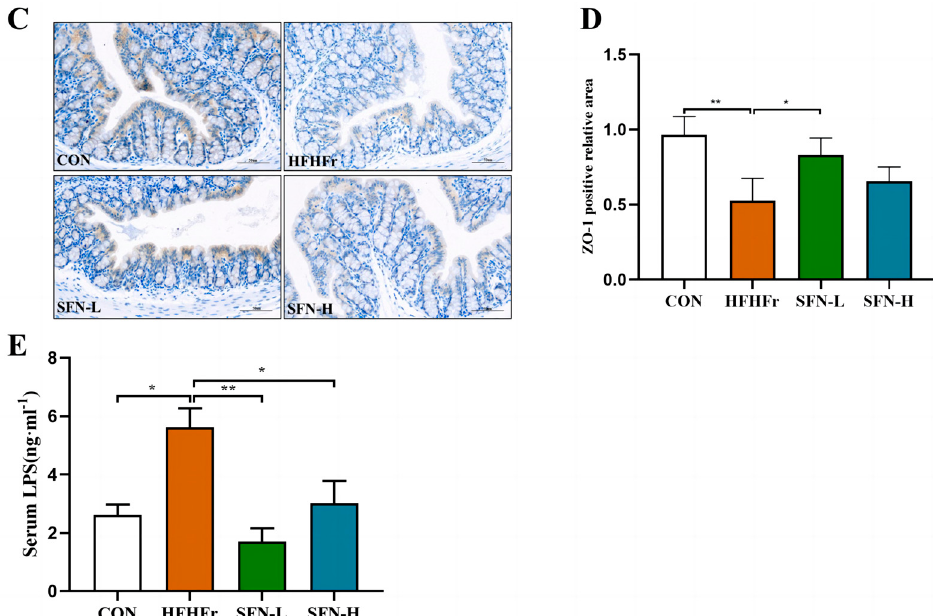
Figure 3. SFN ameliorates intestinal histopathology and improves intestinal permeability in HFHFr mice. ( A ) Representative images of colon tissues stained by H&E staining in mice ( n = 6). ( B ) Relative mRNA levels analysis of ZO-1 and Claudin-4 in colon tissues ( n = 6). ( C ) Representative images of immunohistochemical staining of ZO-1 in colon samples ( n = 6). The scale bar is 50 µ m. ( D ) Quantification of immunohistochemical staining for ZO-1 ( n = 6). ( E ) Serum LPS concentration of each group ( n = 6). Data are shown as mean ± SEM. * p < 0.05, ** p < 0.01 compared with HFHFr.